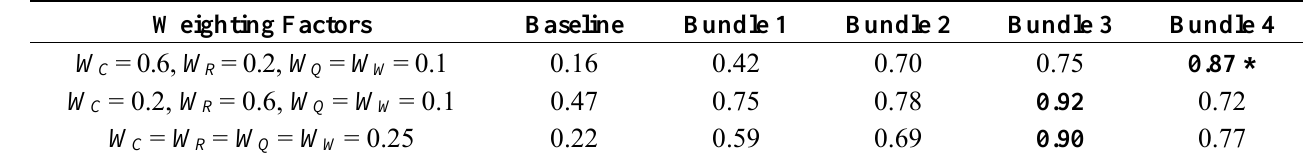
Table 8. Holistic